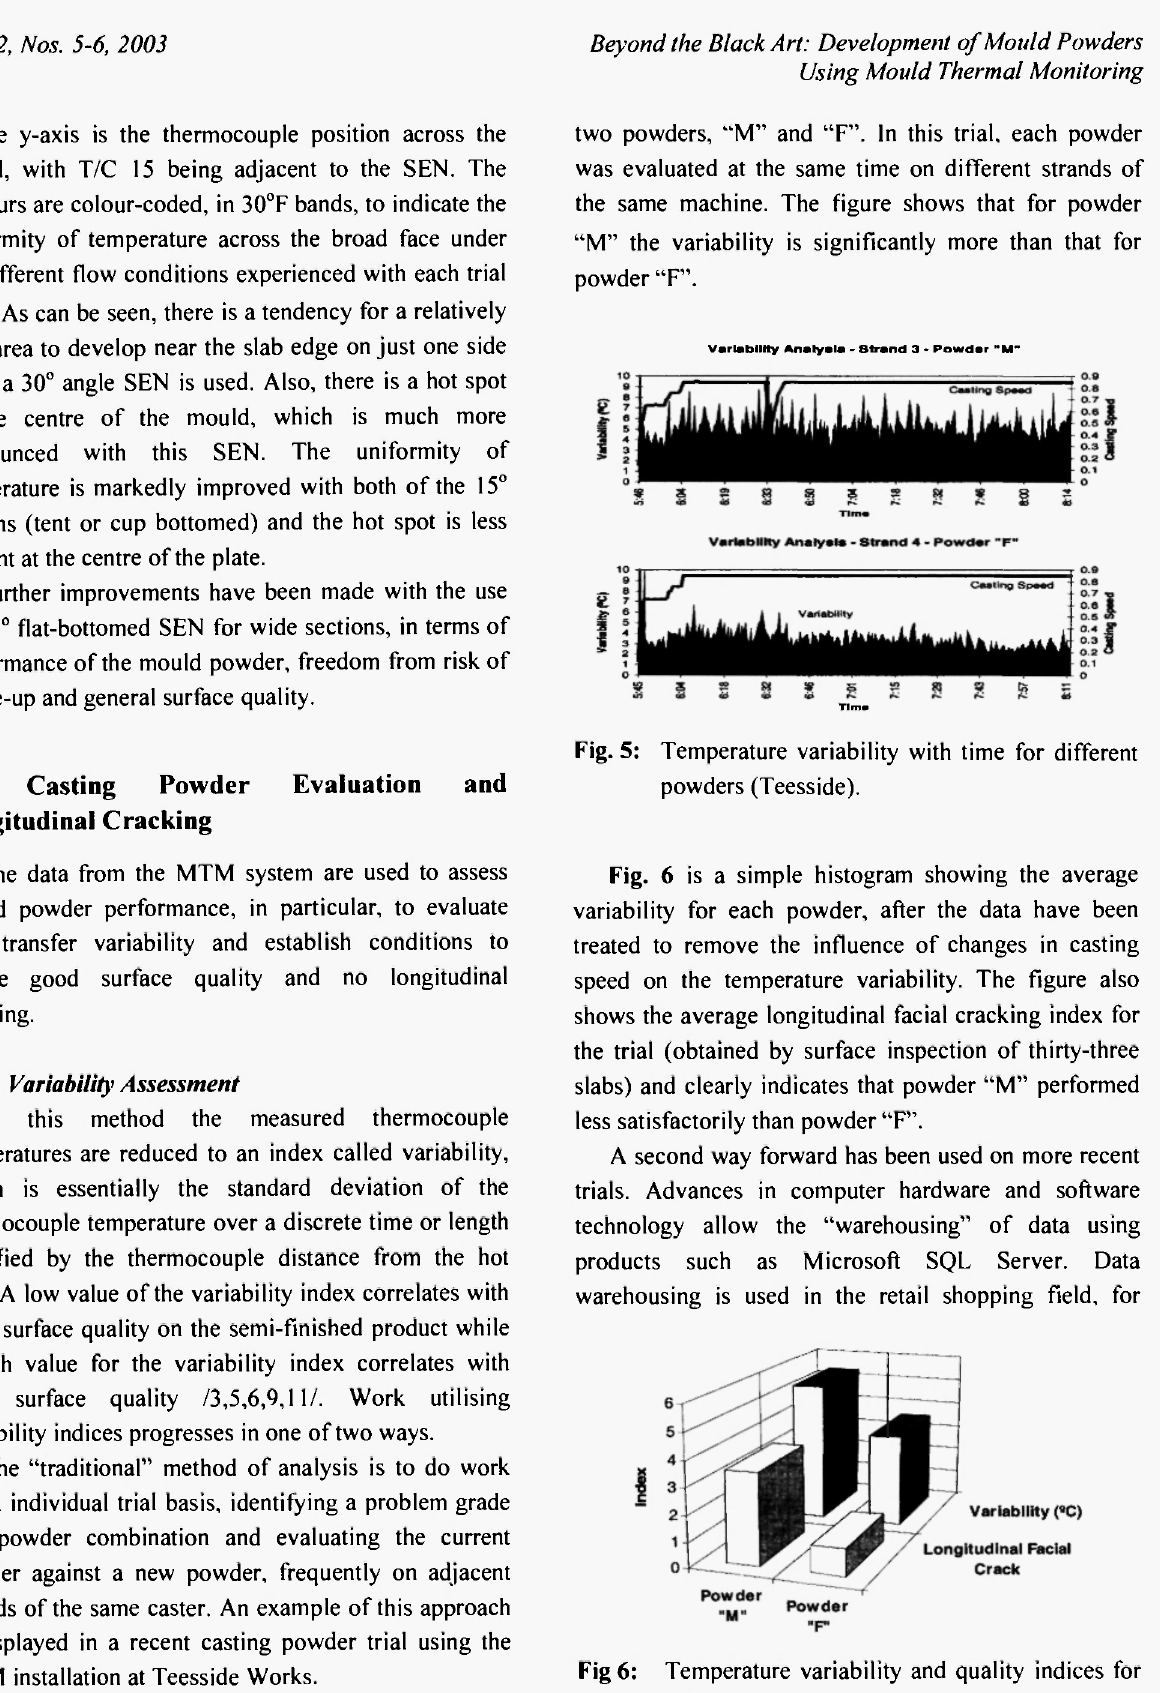
Fig 6: Temperature variability and quality indices for different